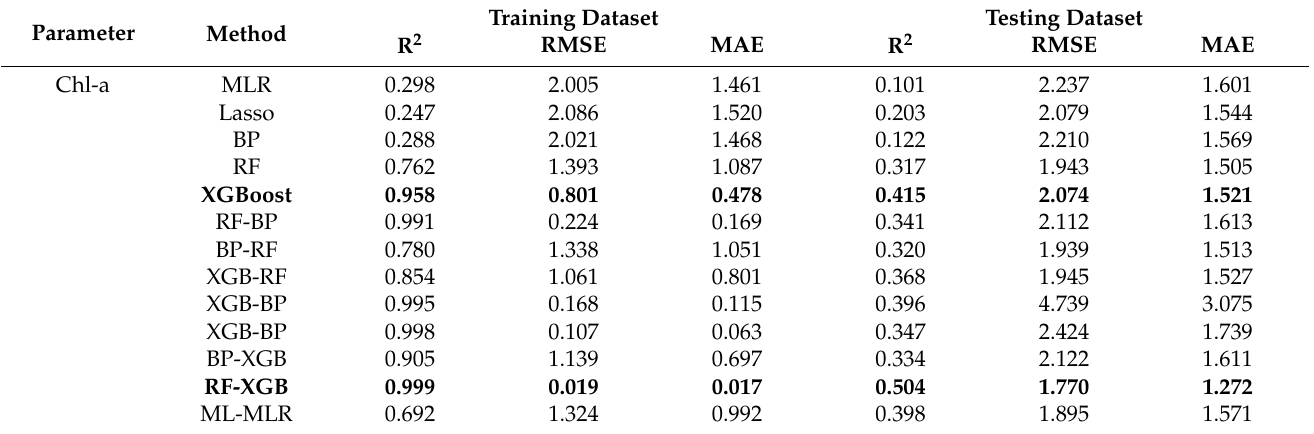
Table 7. Comparison of the performance of single ML models and stacked ML models for Chl-a.